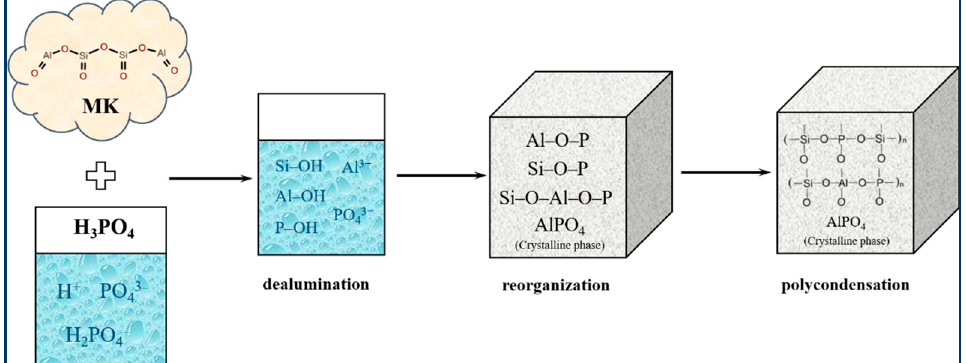
Figure 5. Geopolymerization mechanism of ASP geopolymers (metakaolin is used as aluminosili- cate precursor). cate